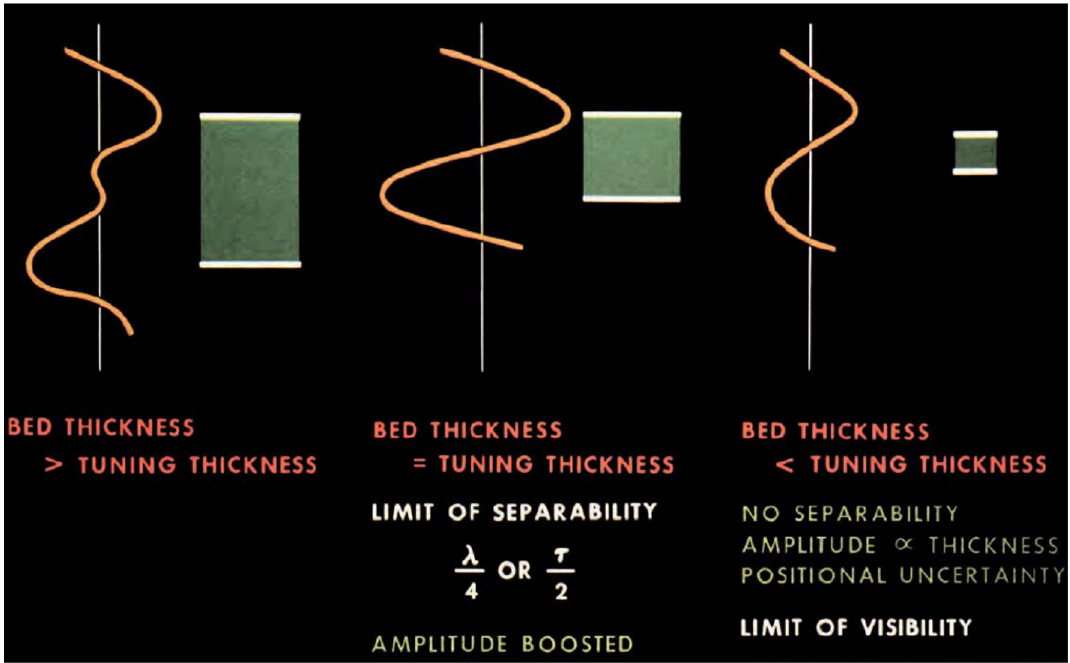
Fig. 6 Resolution of the reflections, from the top and bottom of a bed, is dependent on the interaction of closely spaced wavelets (Brown